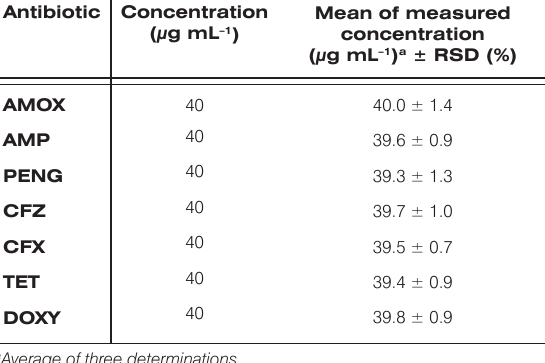
Table 5. The repeatability of the selected antibiotics. Antibiotic Concentration (µg mL –1 )